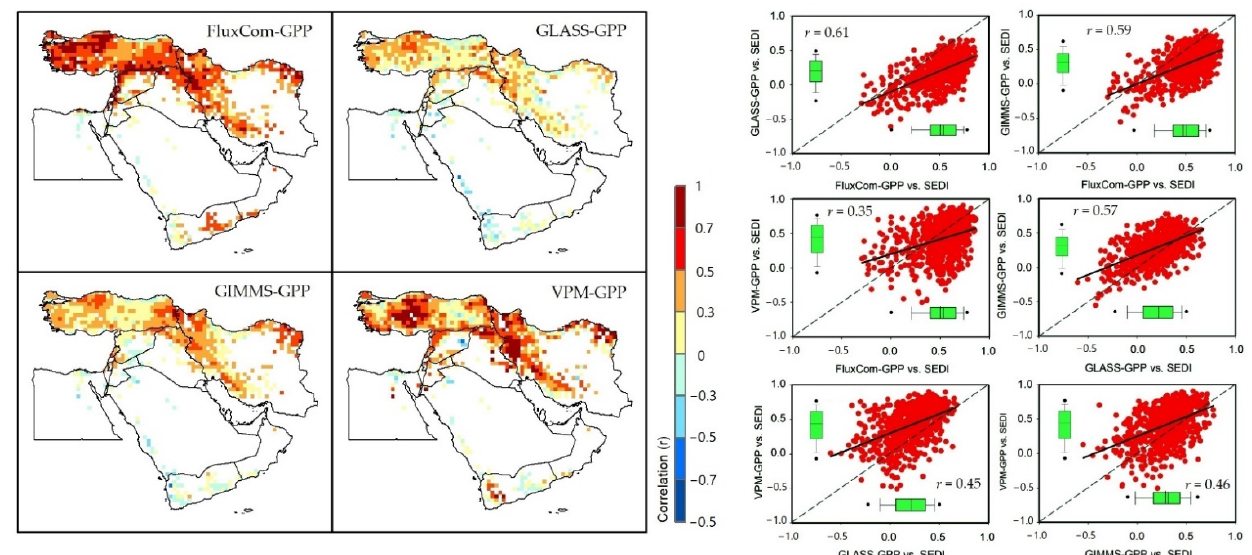
Figure 7. The spatial distribution of correlation values between the four GPP datasets and the SEDI from 1982 to 2016. Right panels indicate the pairwise comparisons, i.e., the cross-correlation value among the GPP models’ responses to the dry-wet condition of the SEDI.